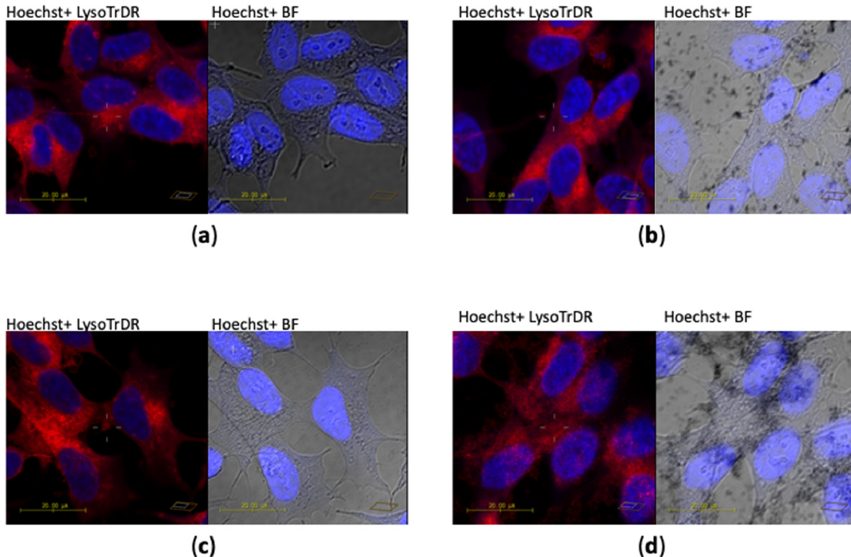
Figure 8. Laser scanning confocal microscopy (LSM) micrographs of SH-SY5Y neuroblastoma cells after 2 hrs treatment with the various samples: ( a ) untreated, ( b ) 5 nM AuNP, ( c ) 20 μ g/mL GO, ( d ) 20 μ g/mL GO-AuNP. Left: merged channels of blue (nuclear staining with Hoechst, λ ex/em = 405/425–475) and red (LysoTracker Deep Red, λ ex/em = 633/650–700); right: merged channels of blue and grey (bright field images). Scale bar = 20 μ m.